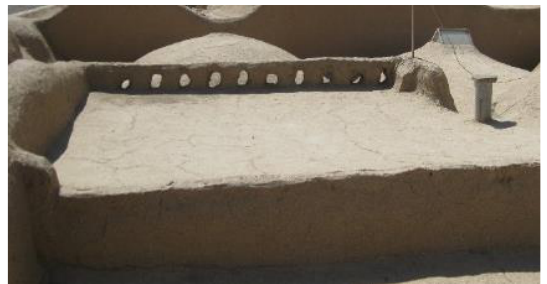
Figure 17. The roof flat for sleeping in summer nights.